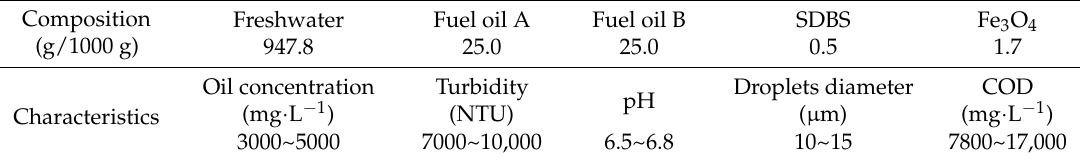
Table 1. The composition and the characteristics of emulsified oil